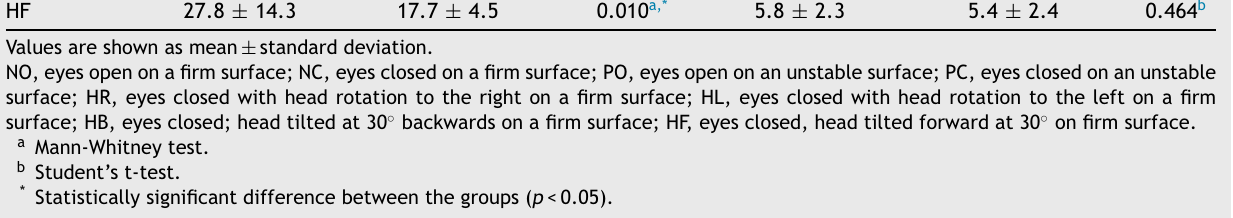
Values are shown as mean ± standard deviation.